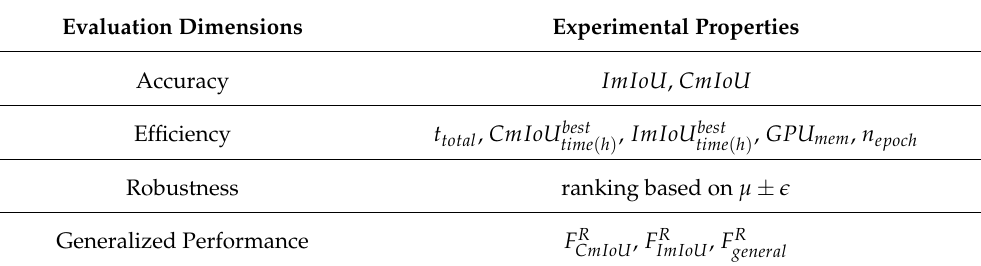
Table 1. Summary of experimental